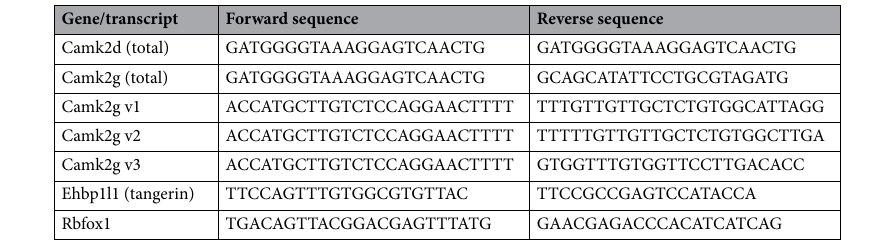
Table 1. Primer sequences for real-time